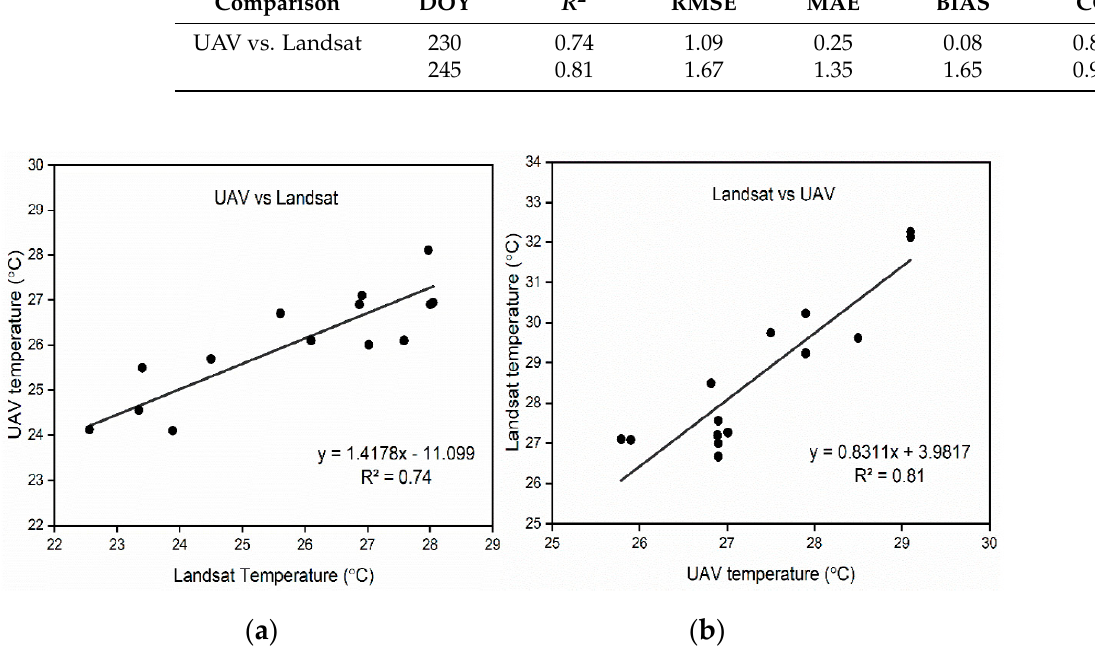
Figure 9. Relationship between Landsat 8-TIR sensor and the ground measurements, ( a ) DOY 230, ( b ) DOY 245. ( b ) DOY